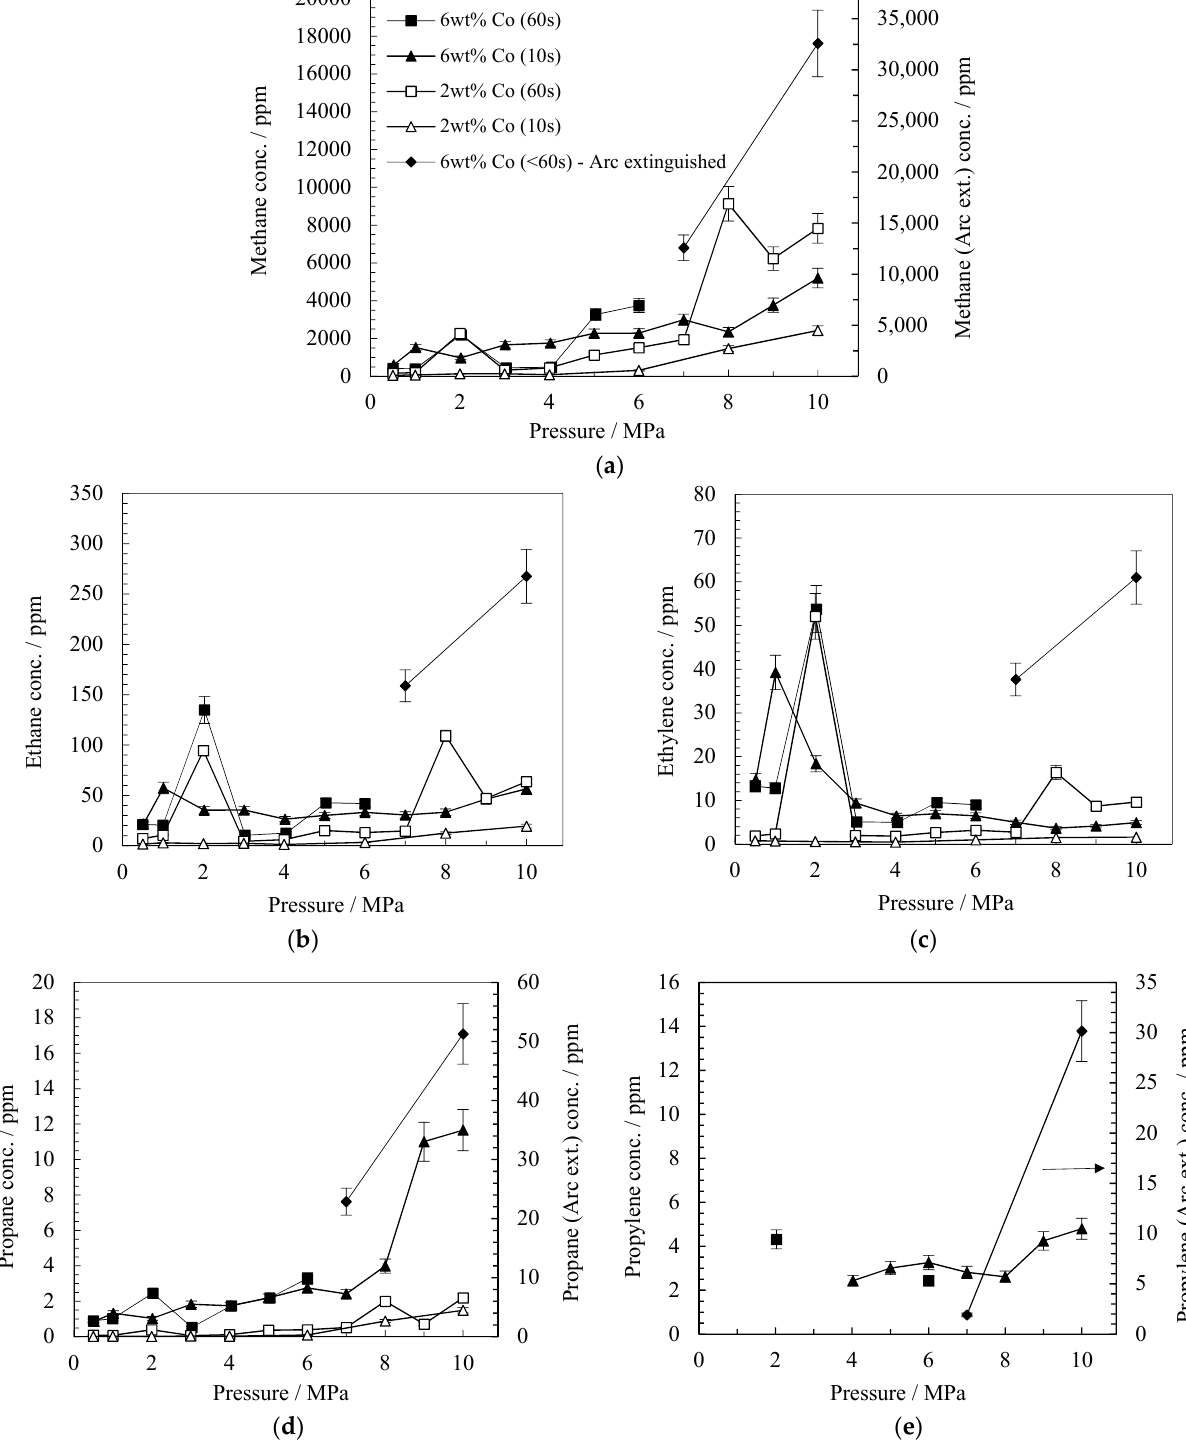
Figure 2. The influence of pressure on hydrocarbon concentration for plasma-catalytic FTS (NTP + 2 or 6 wt% Co catalyst) at discharge times of 10 and 60 s; ( a ) methane, ( b ) ethane, ( c ) ethylene, ( d ) propane and ( e ) propylene. Legend: ■— 6 wt% Co (60 s); ▲ —6 wt% Co (10 s); □ —2 wt% Co (60 s); Δ —2 wt% Co (10 s); ♦ —6 wt % Co (arc extinguished < 60 s). Operating conditions: Syngas (H 2 /CO) ratio: 2.2:1; current: 350 mA; inter-electrode gap: 1 mm; wall temperature: 25 °C. Error bars (vertical): Expanded experimental hydrocarbon concentration uncertainty of ±11%.